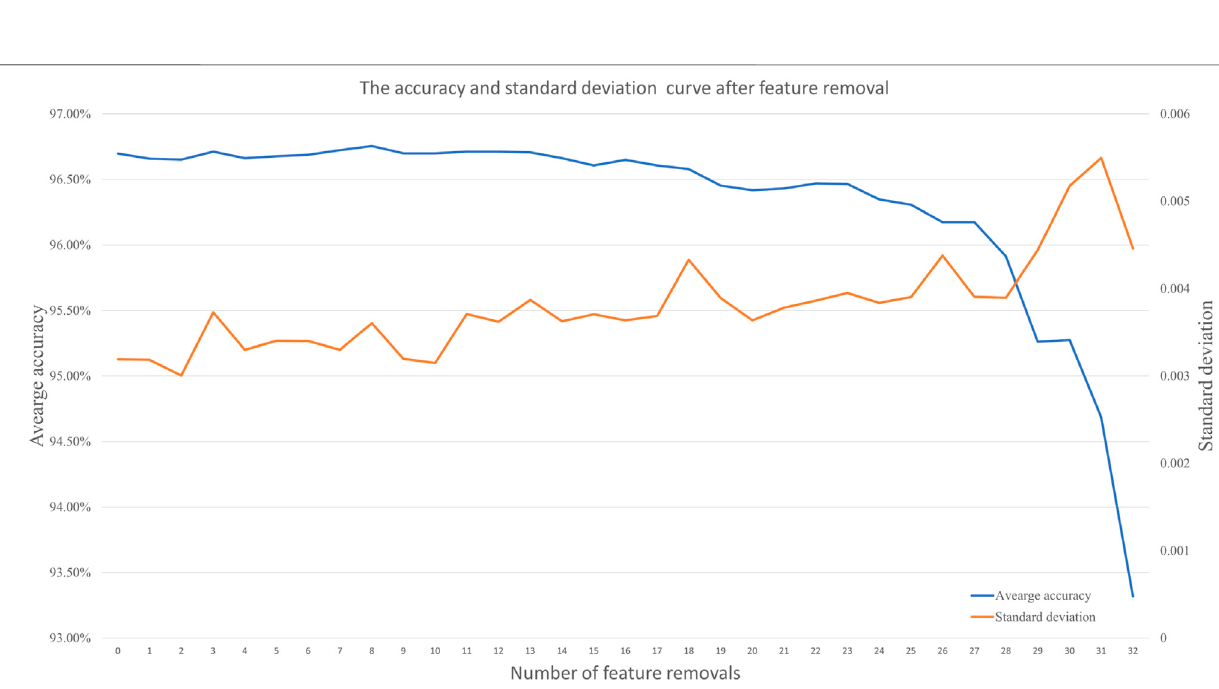
Frontiers in Environmental Science |